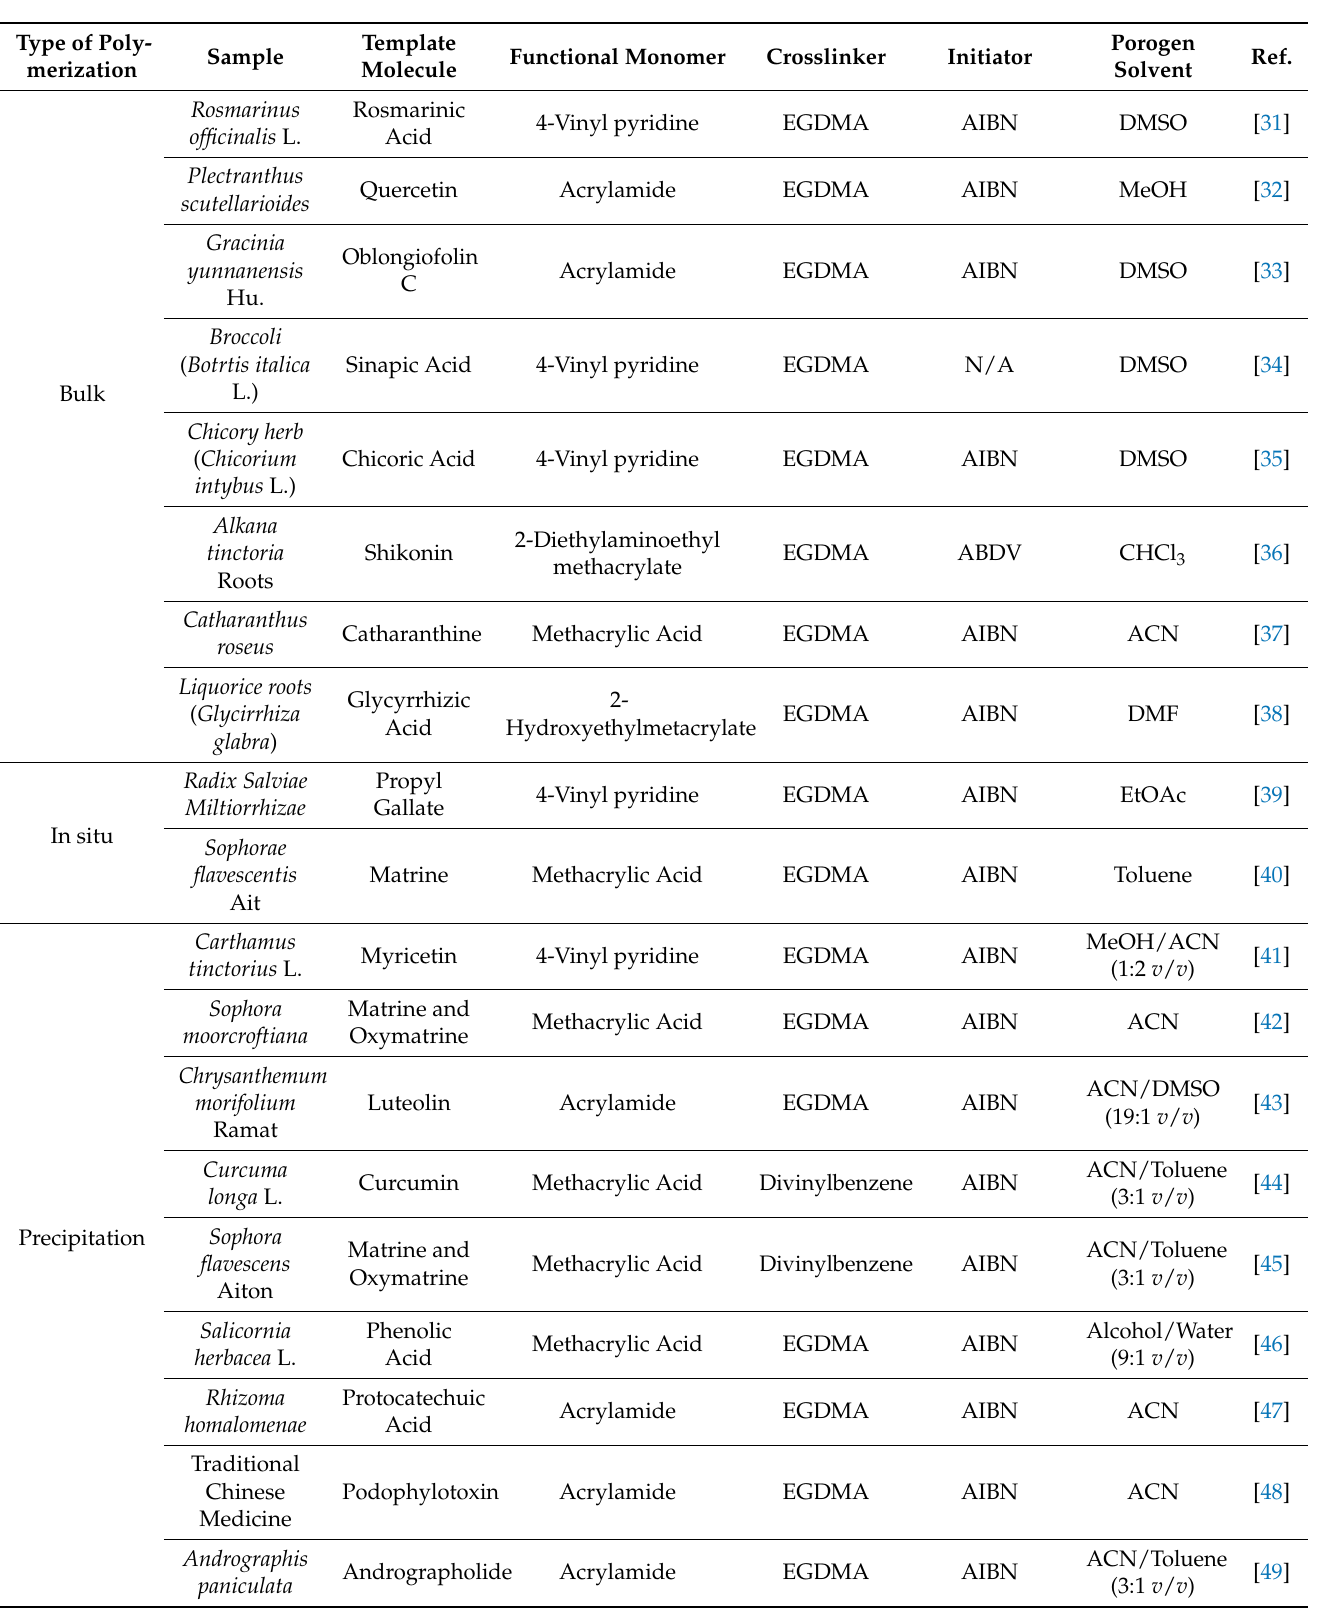
Porogen Solvent